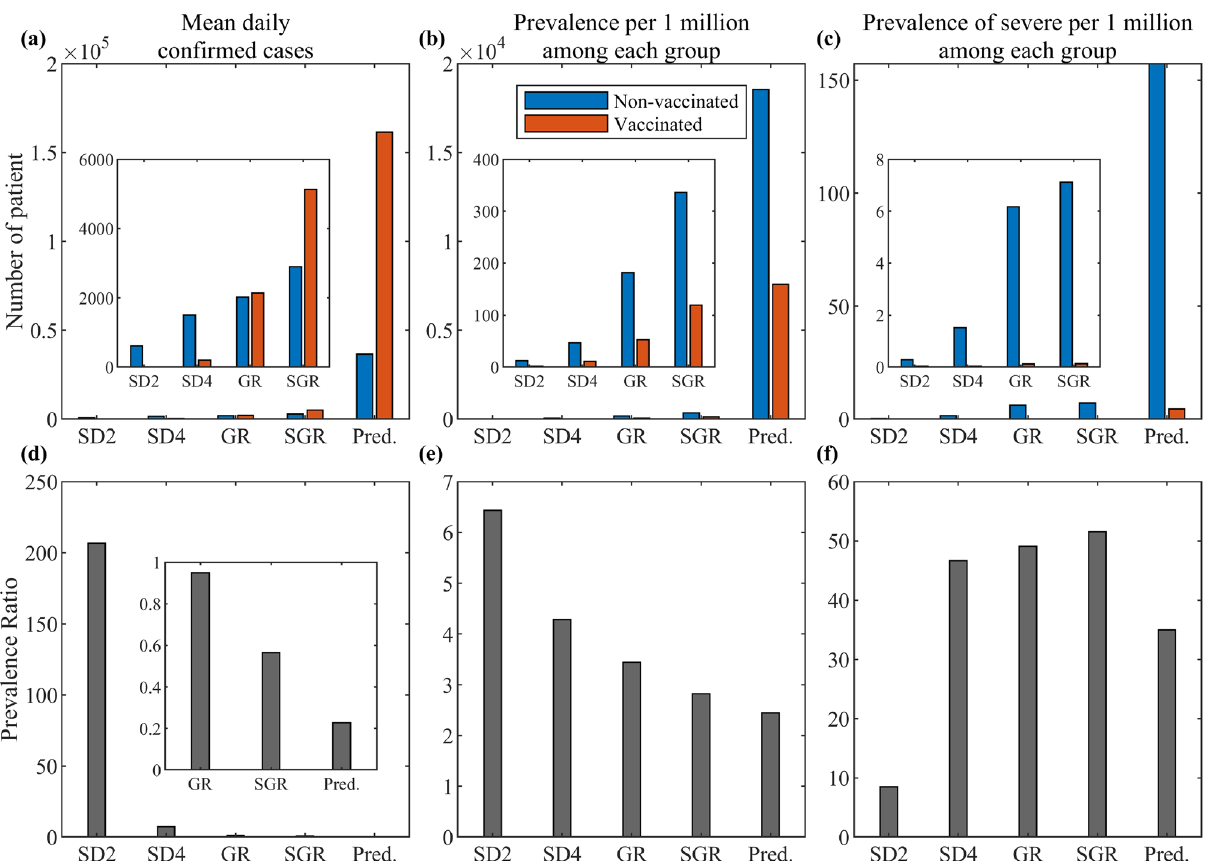
Figure 4. Prevalence of COVID-19 in non-vaccinated and vaccinated classes during the different SD phases and the prediction period. The red, blue, and gray bars show the prevalence of the vaccinated, non-vaccinated, and the prevalence ratio of the non-vaccinated to the vaccinated classes, respectively. The estimation period is from February 26, 2021 to February 2, 2022, and the prediction period is from February 3, 2022 to November 30, 2022. Panel ( a ) shows the mean daily confirmed cases, ( b,c ) prevalence of a case and severe case per one million, and ( d–f ) prevalence ratio calculated as (prevalence of non-vaccinated)/(prevalence of vaccinated). The insets show a magnification of the less visible bar